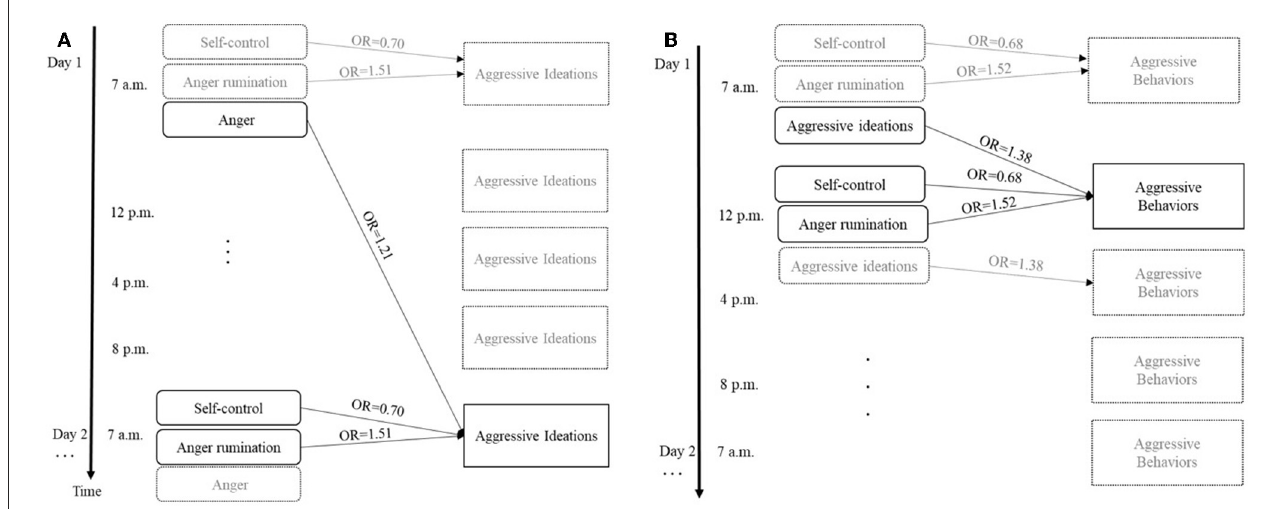
FIGURE2 (A) Results of the analyses for aggressive ideations (B) Results of the analyses for aggressive behaviors. The Figure avoids overlapping arrows, though same pattern applies to every momentary assessment (e.g., aggressive behaviors at 12 p. m. are also associated with the predictors at 12 p. m., etc.). For illustration purpose, only significant results were marked with arrows. OR, Odd